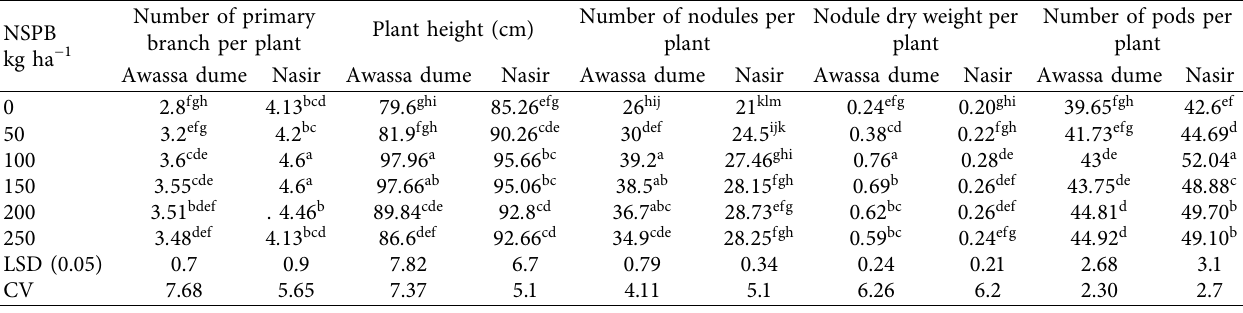
Table 2: Interaction efects of varieties and blended NPSB fertilizer rates on growth parameters of common bean at Meskan District in 2020 cropping season.